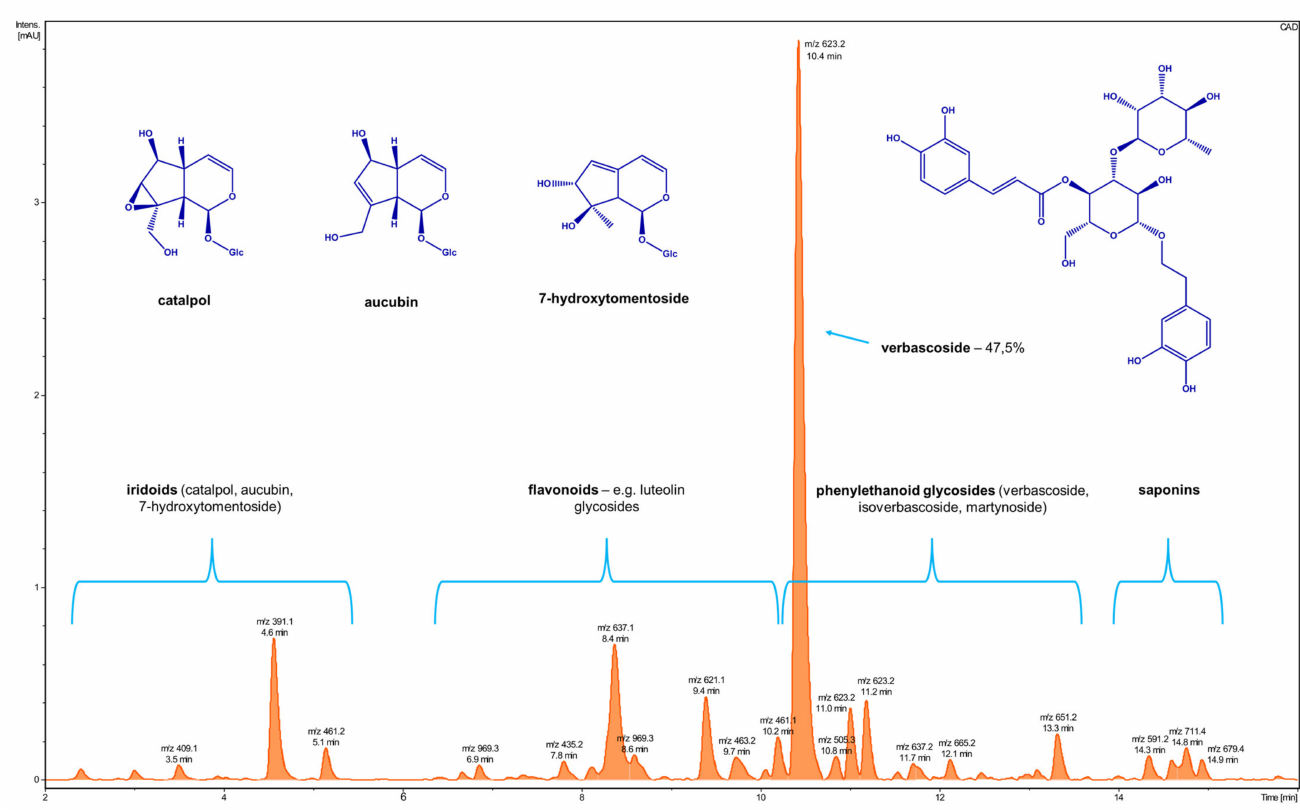
Figure 1. The UHPLC-CAD profile of a Paulownia Clon In Vitro 112 ® extract of leaves from Ł˛eka. Multi-step chromatographic separation led to the isolation of several polyphenolic constituents—derivatives of a disaccharide α - L -rhamnopyranosyl(1 → 3)- D -glucopyranose— verbascoside (1), verbascoside (2) and cistanoside F (3); and a glycosylated flavone clerodendrin—apigenin 7- O -[ β - D -glucuronopyranosyl(1 → 2)- β - D -glucuronopyranoside] (4); but also two iridoid glycosides—catalpol (5) (as a mixture) and 7-hydroxytomentoside (6) (Figure 2). Their identity was confirmed by means of accurate mass measurements, MS/MS fragmentation patterns, ultraviolet-visible (UV-Vis) spectra, 1D and 2D